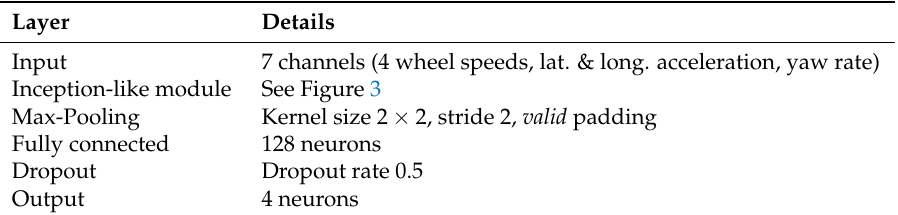
Table 1. Architecture for the evaluation of different